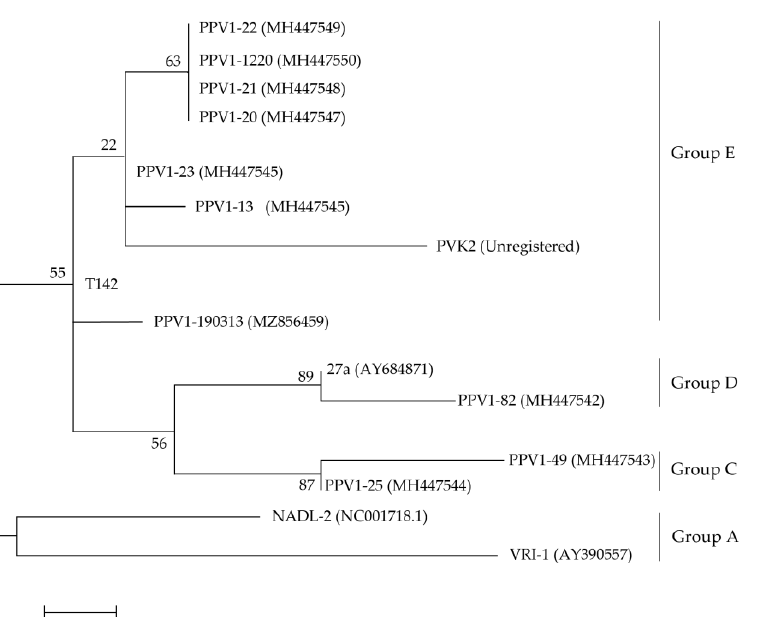
Figure 1. Phylogenetic analysis based on PPV1 VP2 gene sequences. The maximum-likelihood method (Tamura-Nei model of nucleotide substitution, gamma distributed with invariant sites) was used in molecular epidemiology and analysis of rapidly evolving heterochronos PPV1 VP2 sequences, with the 1000 bootstrap replicates setting of the MEGA v 6.0 program. VP2 amino acid sequences of the ten PPV1s isolated from Korean pig farms were compared with the reference sequences PVK2, T142, 27a, NADL-2, and VRI-1. GenBank Accession numbers are provided in the parentheses next to each strain name. The log likelihood (log L) value for the genome sequences was − 28,543.99. Bootstrap values are indicated at the nodes. The scale bar indicates the number of nucleotide substitutions per site.